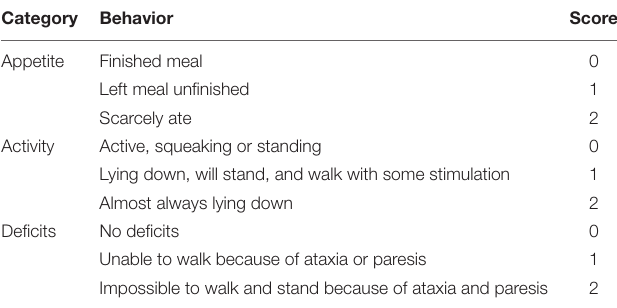
TABLE 1 | Behavior